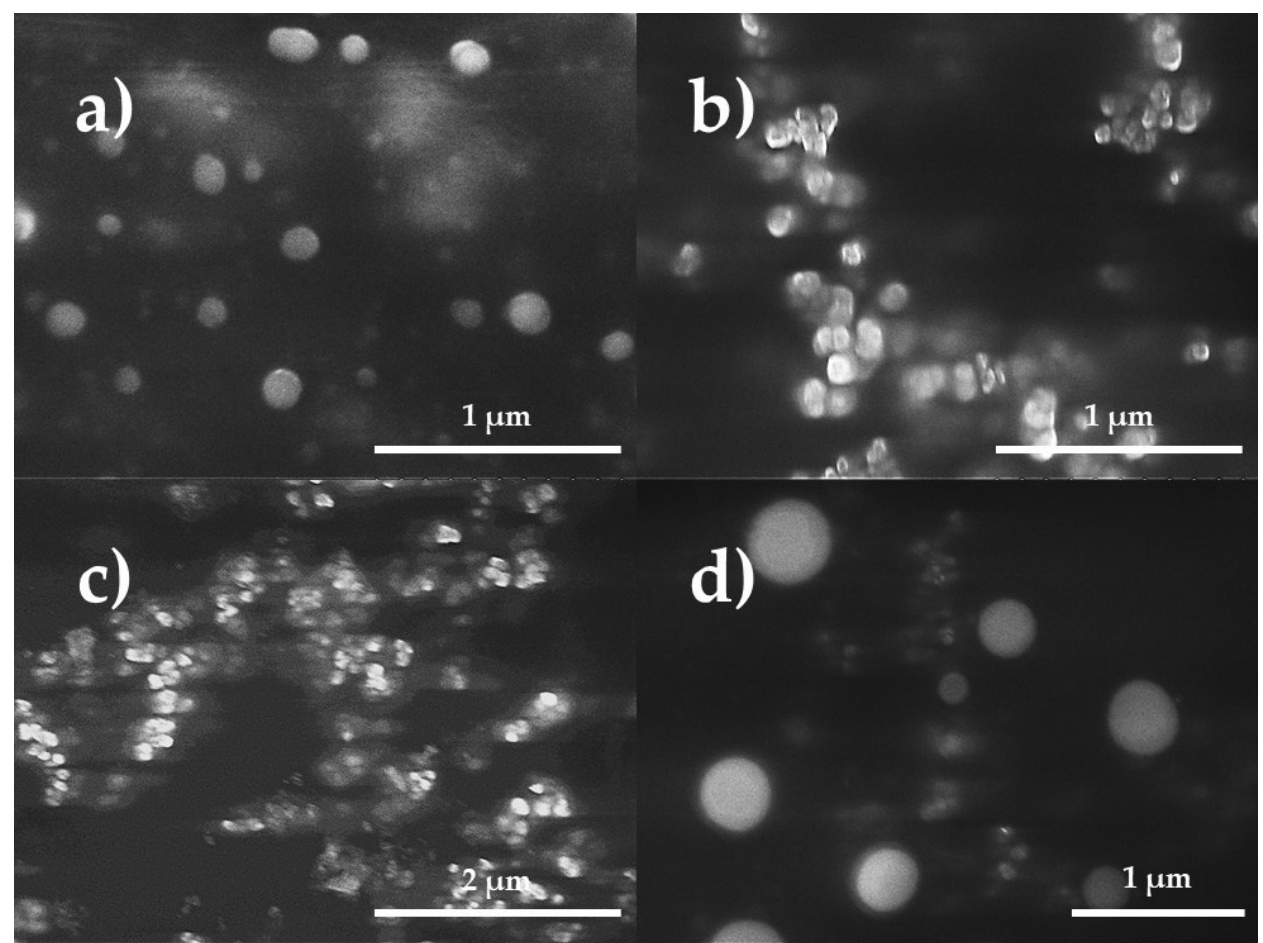
Figure 2. Morphological characterization by SEM of the nanocapsules ( a ) without charge, ( b ) loaded with thyme essential oil, ( c ) loaded with active in week 5 of storage at 25 °C, and ( d ) loaded with thyme essential oil in week 5 of storage at 4 °C.